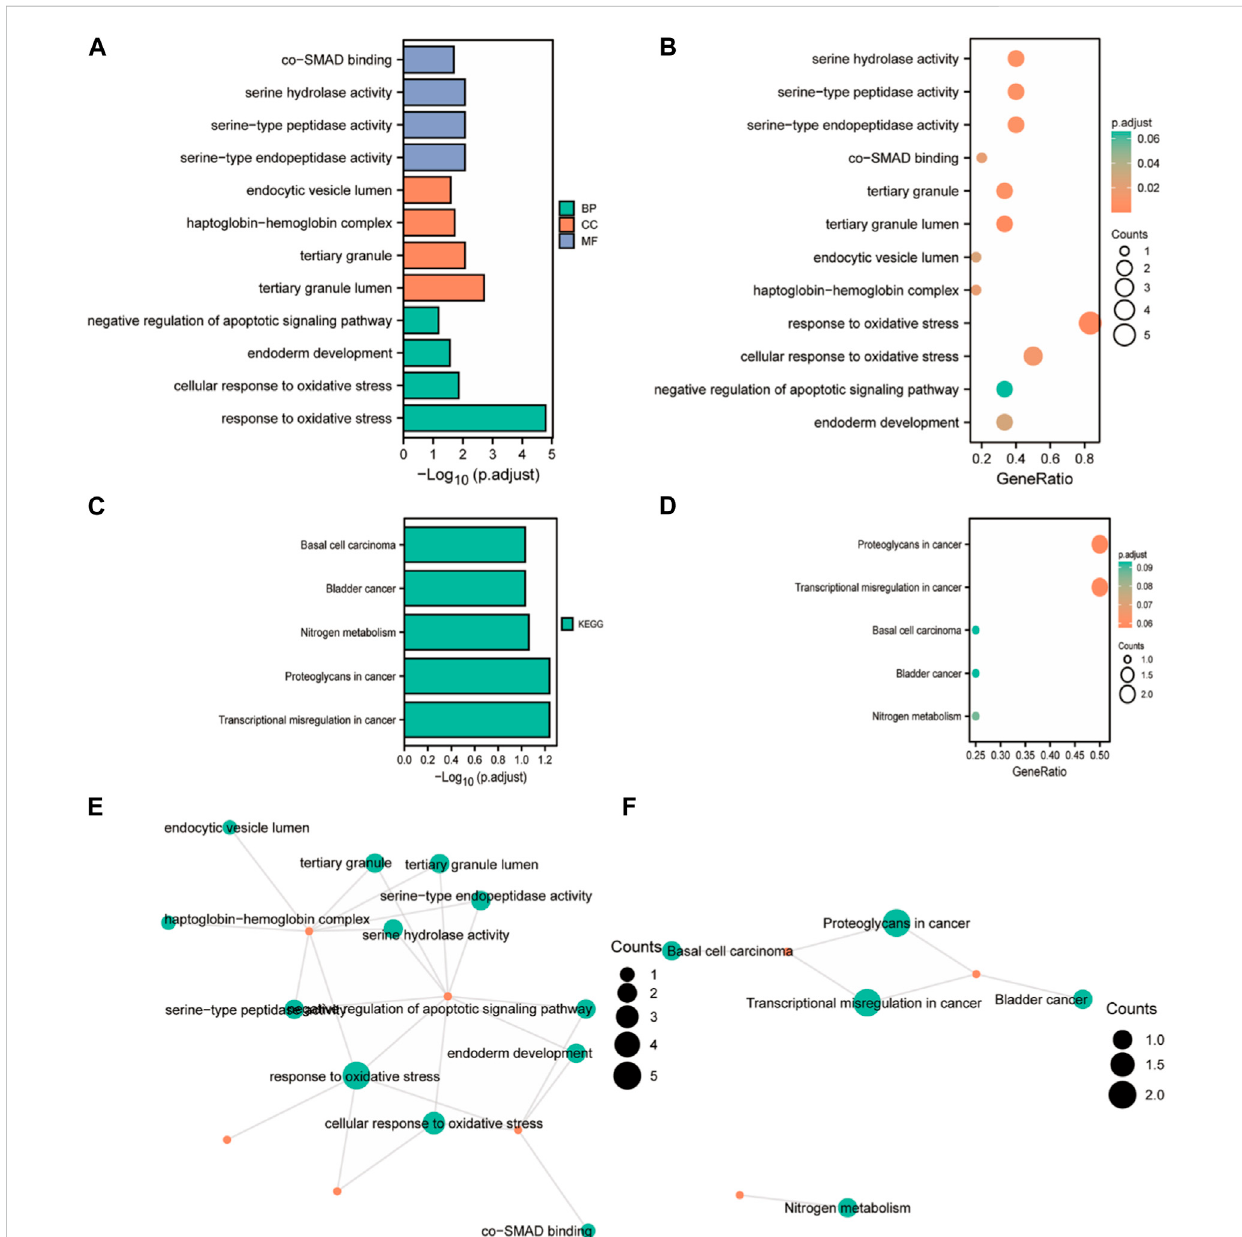
FIGURE 10 GO/KEGG enrichment analysis of closely related oxidative stress co-expressed genes. (A, B) Bar chart and bubble chart of GO enrichment analysis; (C, D) KEGG enrichment analysis bar chart and bubble chart; (E, F) chordal diagram of GO and KEGG enrichment